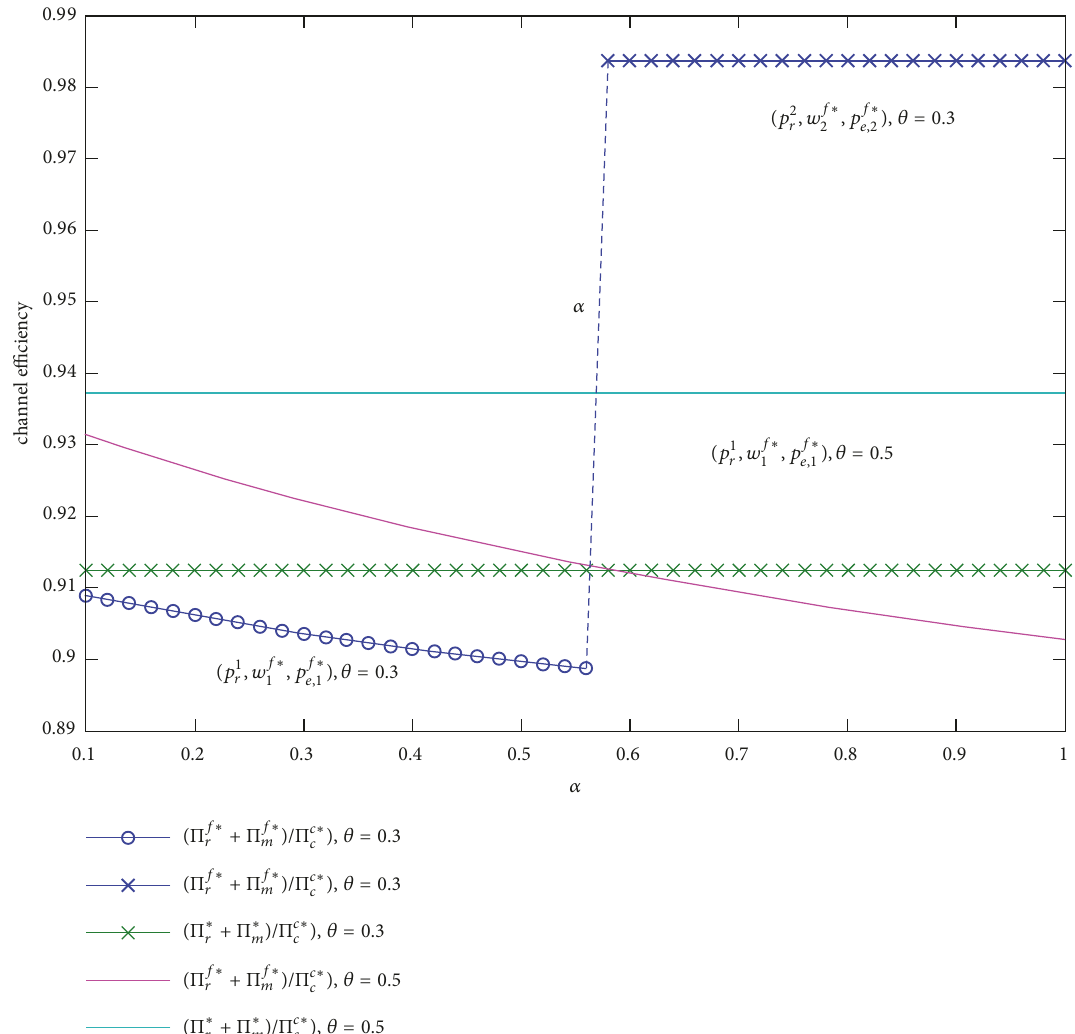
Figure 7: Impact of 𝜃 and 𝛼 on channel efficiencies for the two